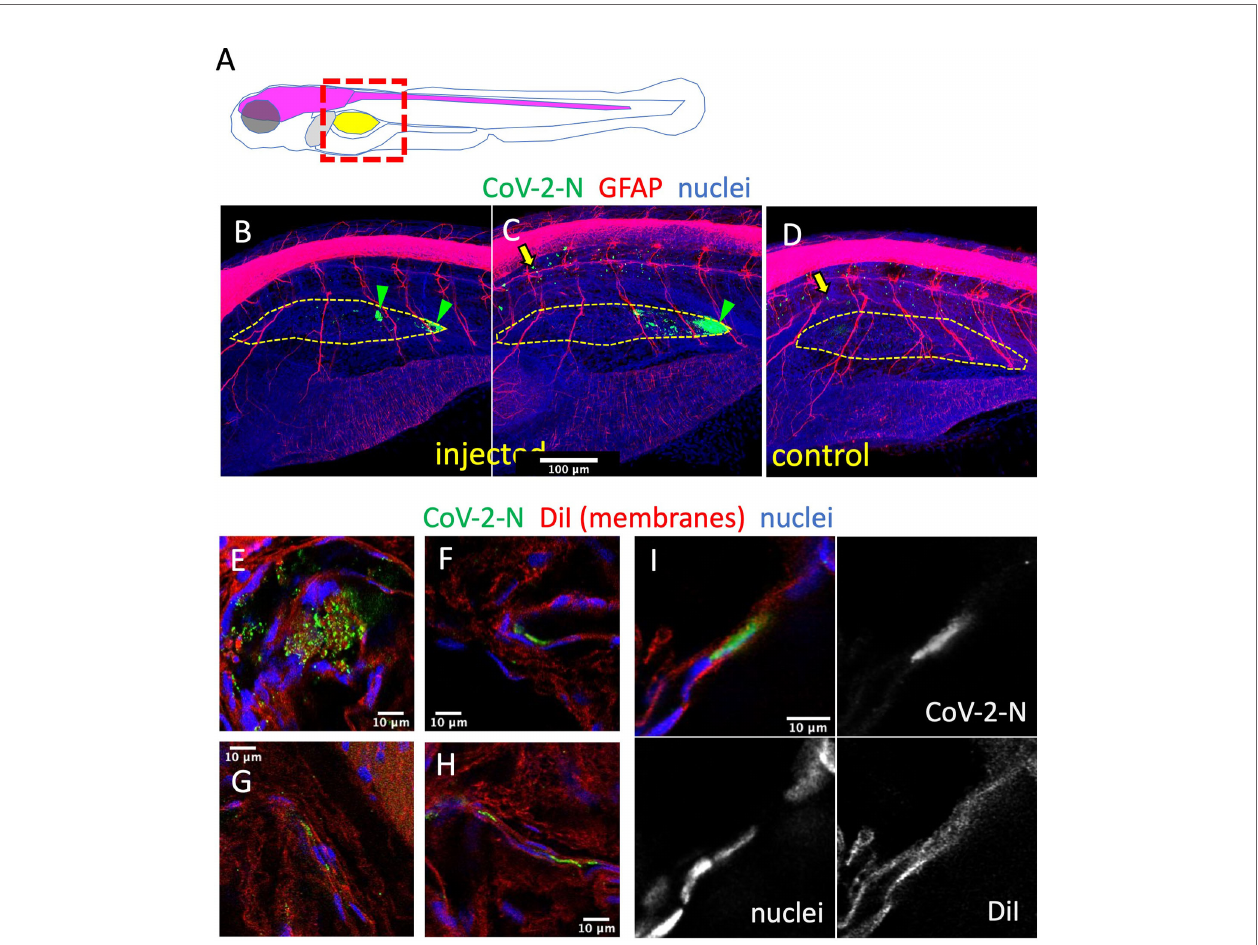
FIGURE 5 | Immunodetection of infected cells in the swim bladder. (A) Scheme of the imaged region: the swim bladder is shown in yellow, the brain and spinal cord in magenta, the liver in gray. (B – F) Confocal images of SARS-CoV-2-injected (B, C, E – I) or uninjected (D) larvae fi xed at 2 dpi and subjected to whole-mount immunohistochemistry with an anti-CoV-2-N antibody (green), an anti-GFAP antibody (red in B – D ) or membranes stained by DiI (red in E – I ), and stained nuclei (blue). (B – D) Maximal projections. The approximate contours of the partially collapsed swim bladders are shown with a dotted yellow line. N-positive cells shown with green arrowheads. Yellow arrows point to non-speci fi c punctate signal in the notochord. (E – I) Single confocal